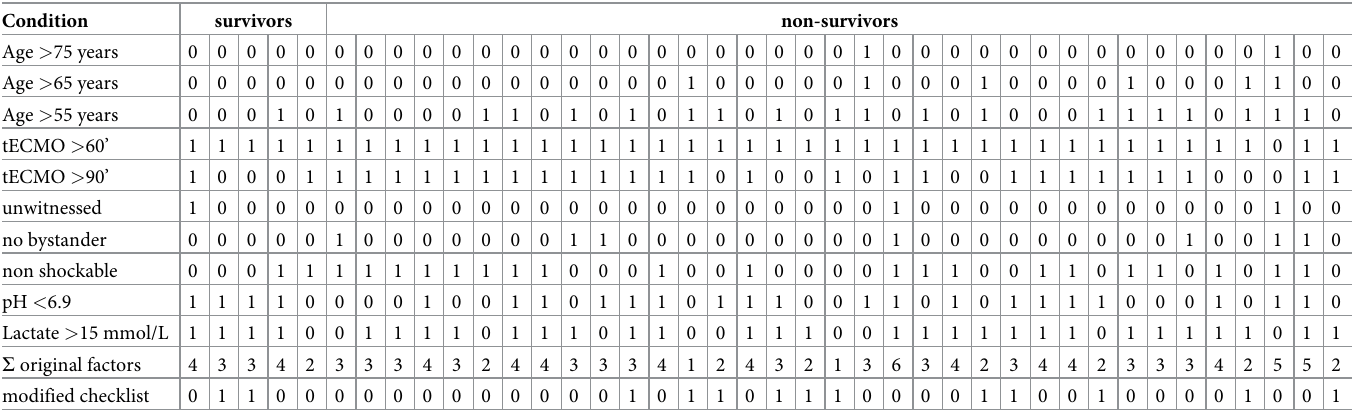
Table 2. Non-favourable conditions.